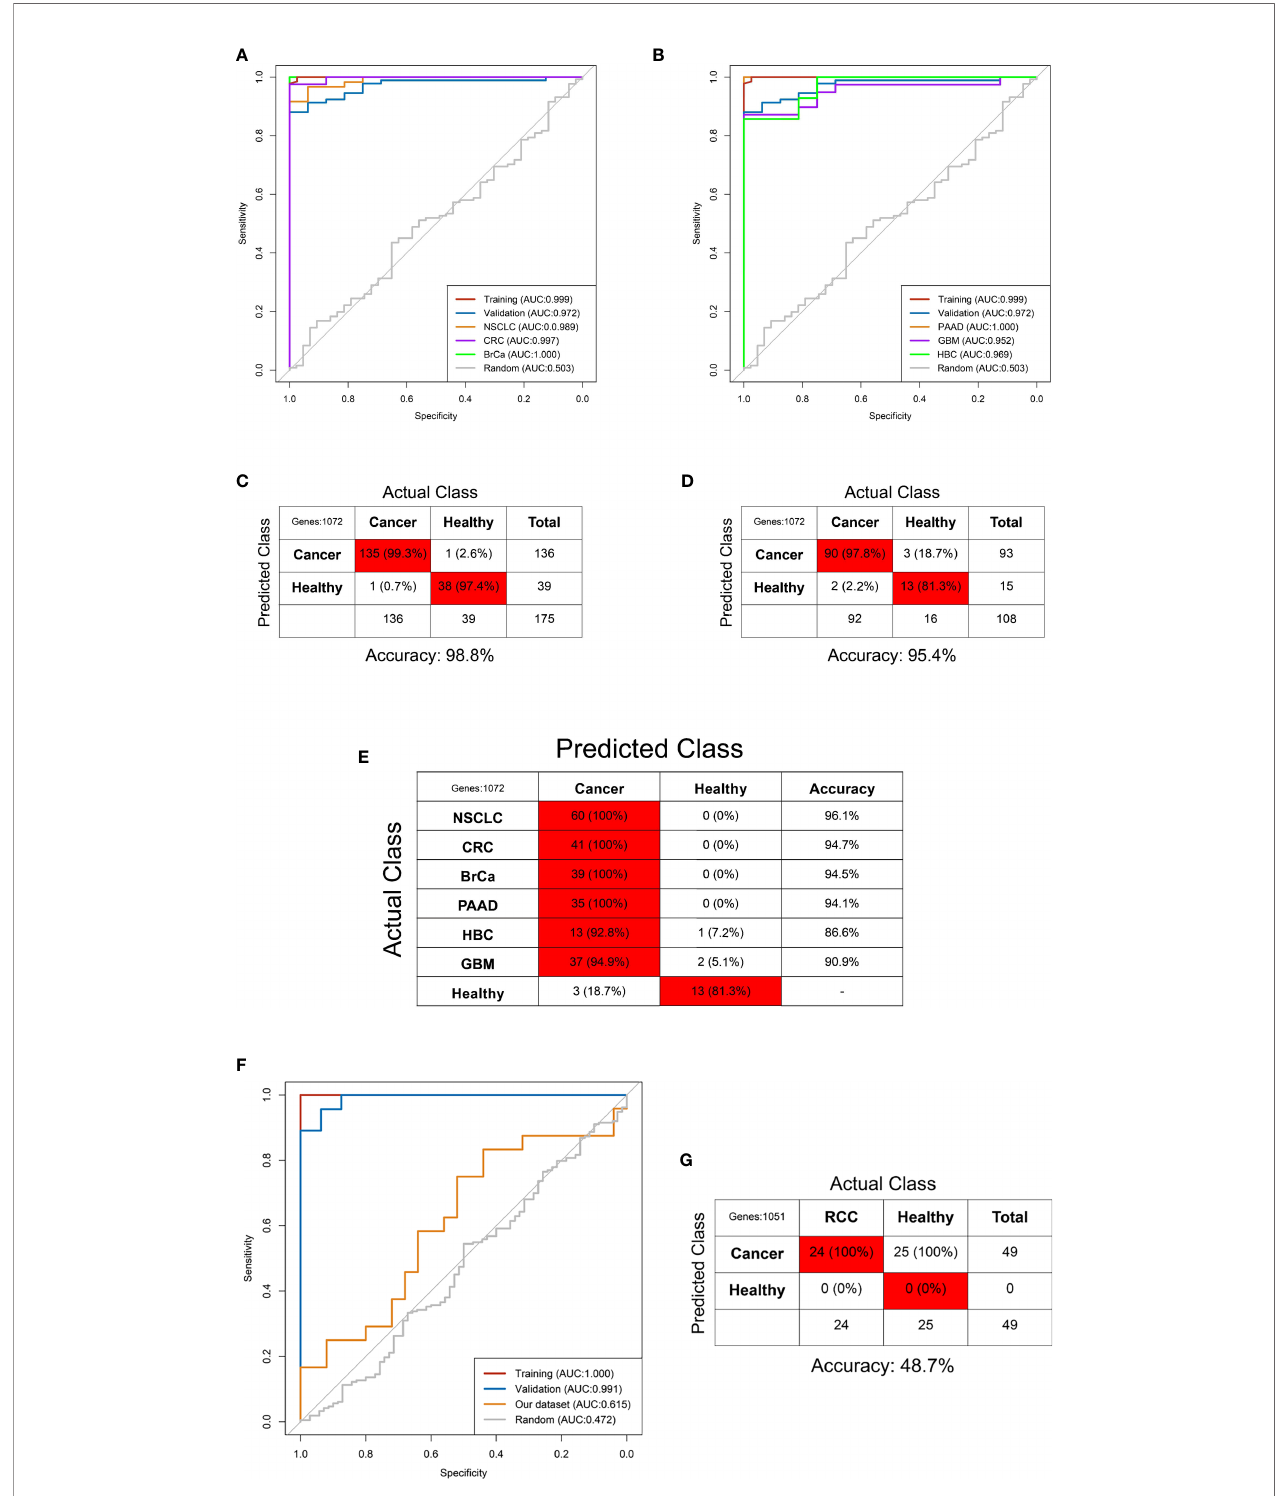
FIGURE 4 | Predictive accuracy of the pan-cancer TEP model shown by the ROC curves in the internal (A, B) and external validation (F) and the confounding matrix in the training (C) , validation (D) , and internal different tumor types (E) and external RCC patients (G)